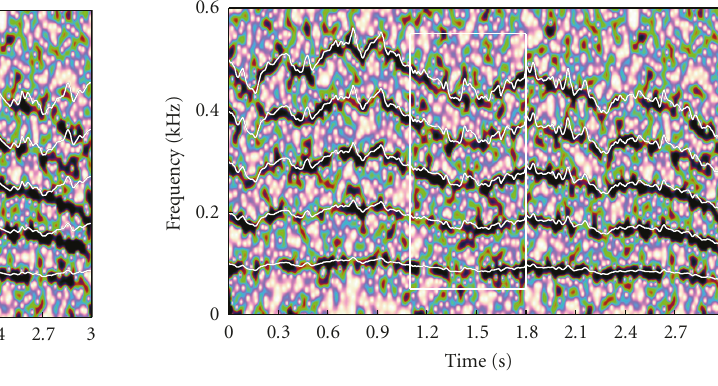
(b) Spectrogram of a true signal with the estimated harmonics (white lines) using the FBSL-SPKS frequency tracker Figure 1: (a) EKS Frequency Estimate and (b) FBSL-SPKS Frequency Estimate. The black area in the spectrograms represents great power concentrated in the corresponding frequency at a given time.